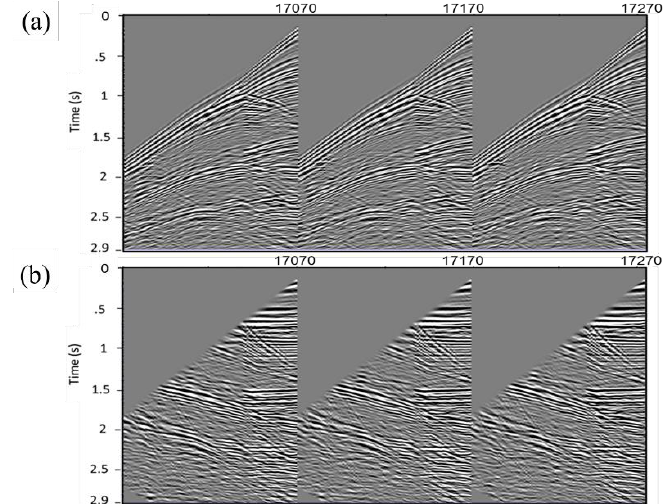
Figure 9. Seismic gather data ( a ) before the NMO correction and ( b ) after the NMO correction. Events are slightly straight at the true reflection points.